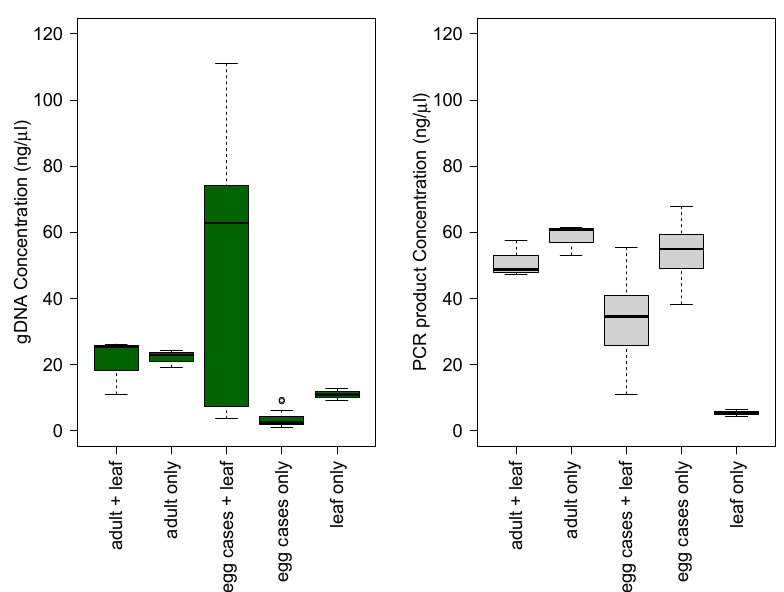
Figure 2. Boxplots of median, lower, and upper quartiles of genomic DNA concentration and PCR product concentration for proof-of-concept tissue treatments: adult + leaf (n = 3; positive control), adult only (n = 3; positive control), egg cases + leaf (n = 15), egg cases only (n = 15), and leaf only (n = 3, negative control). Because there was no significant di ff erence in yield between number of storage days for egg cases + leaf and egg cases only (F = 3.864, p = 0.0569) all storage day treatments were pooled within tissue type